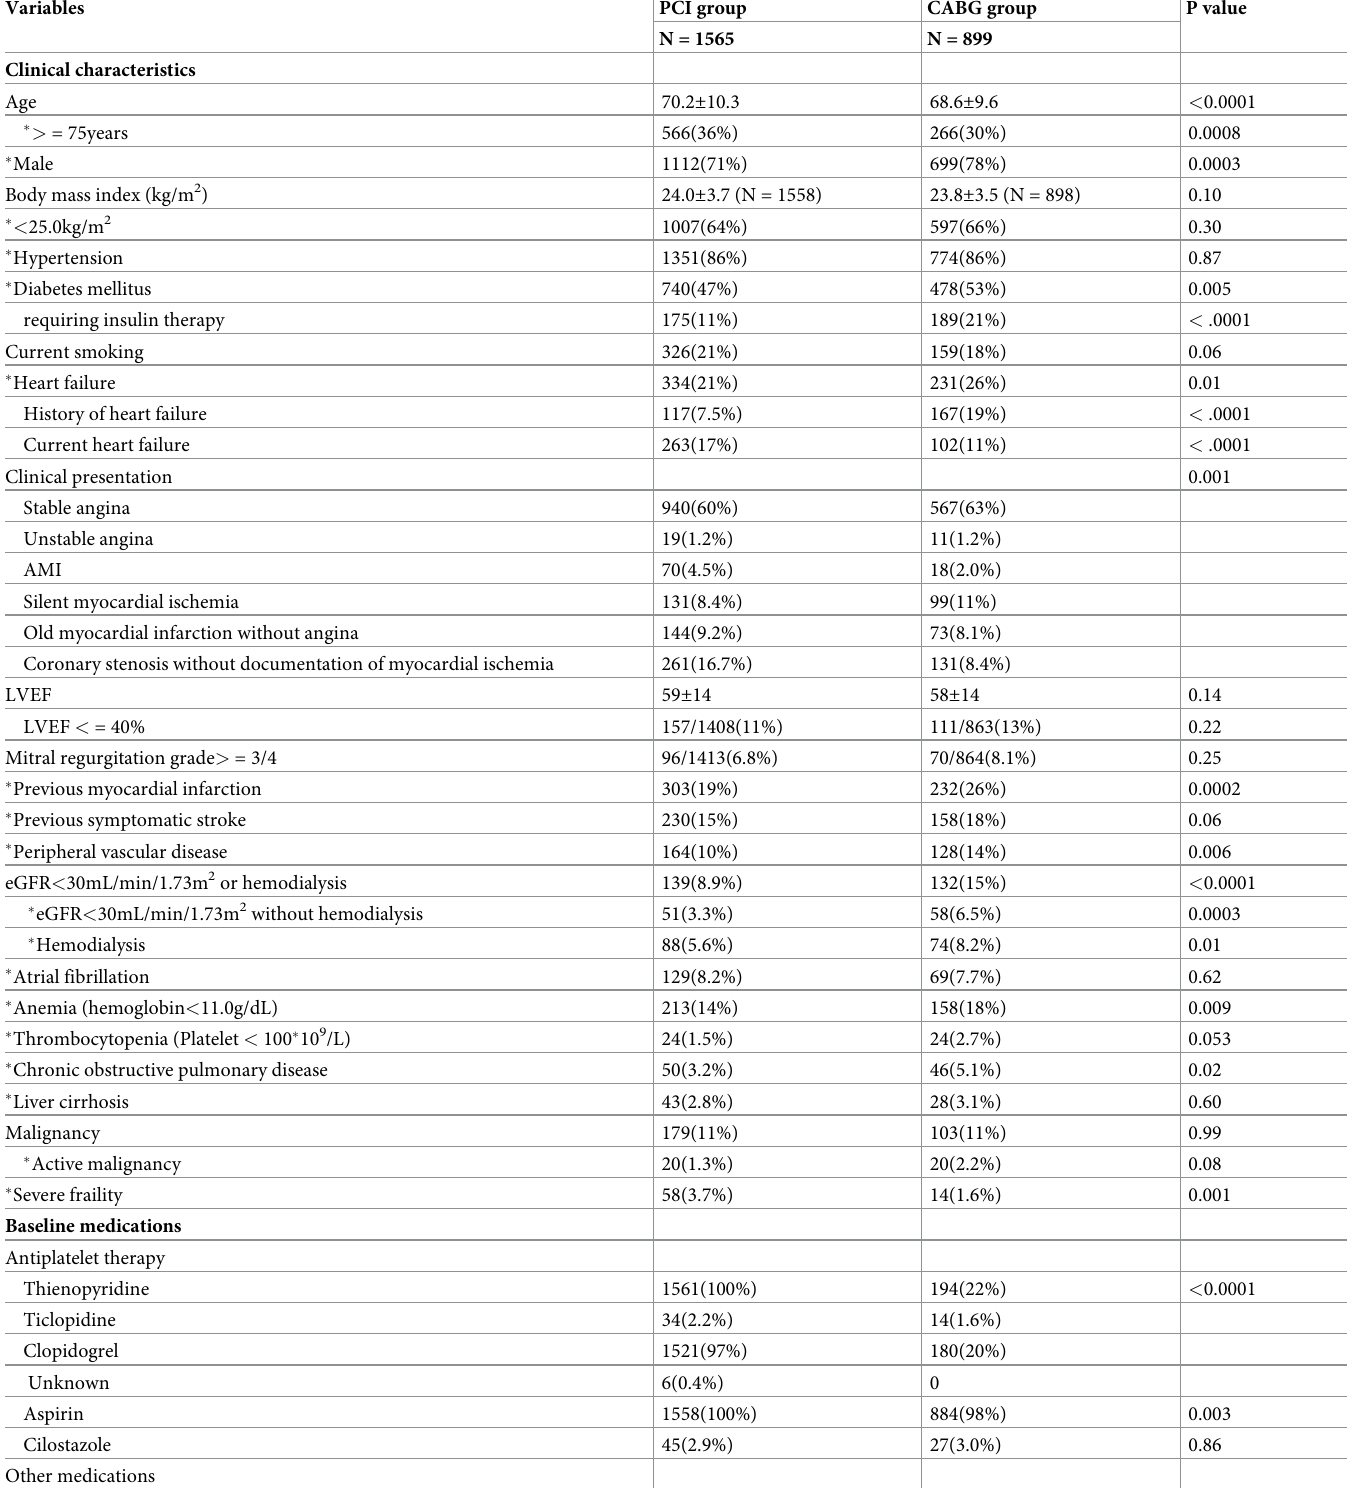
Table 1. Baseline characteristics and medications during the index hospitalization: PCI group versus CABG